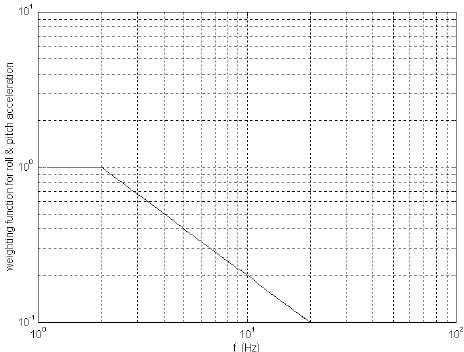
Figure 11. Frequency weighting function for roll and pitch acceleration.